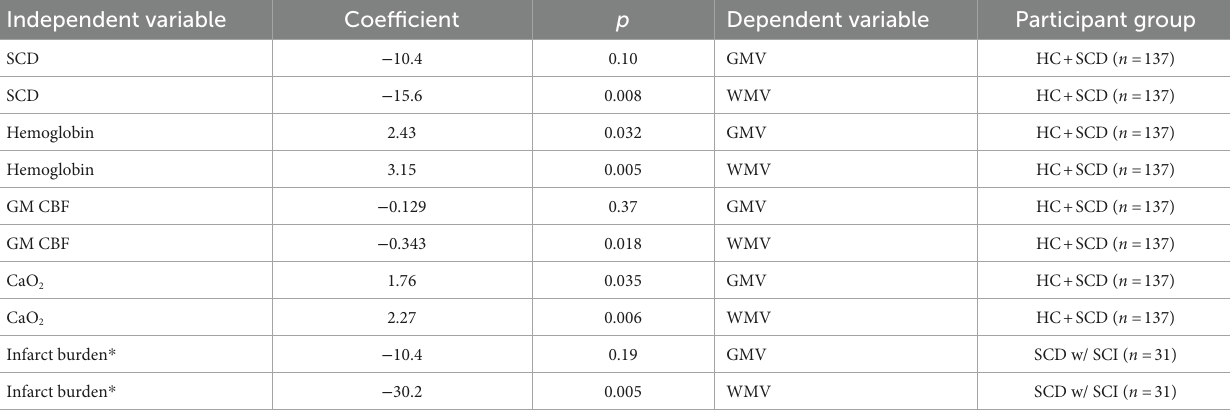
TABLE 2 Components of multivariable linear regression models for predicting gray and white matter volume (primary analysis), organized by independent variables of interest. Independent variable